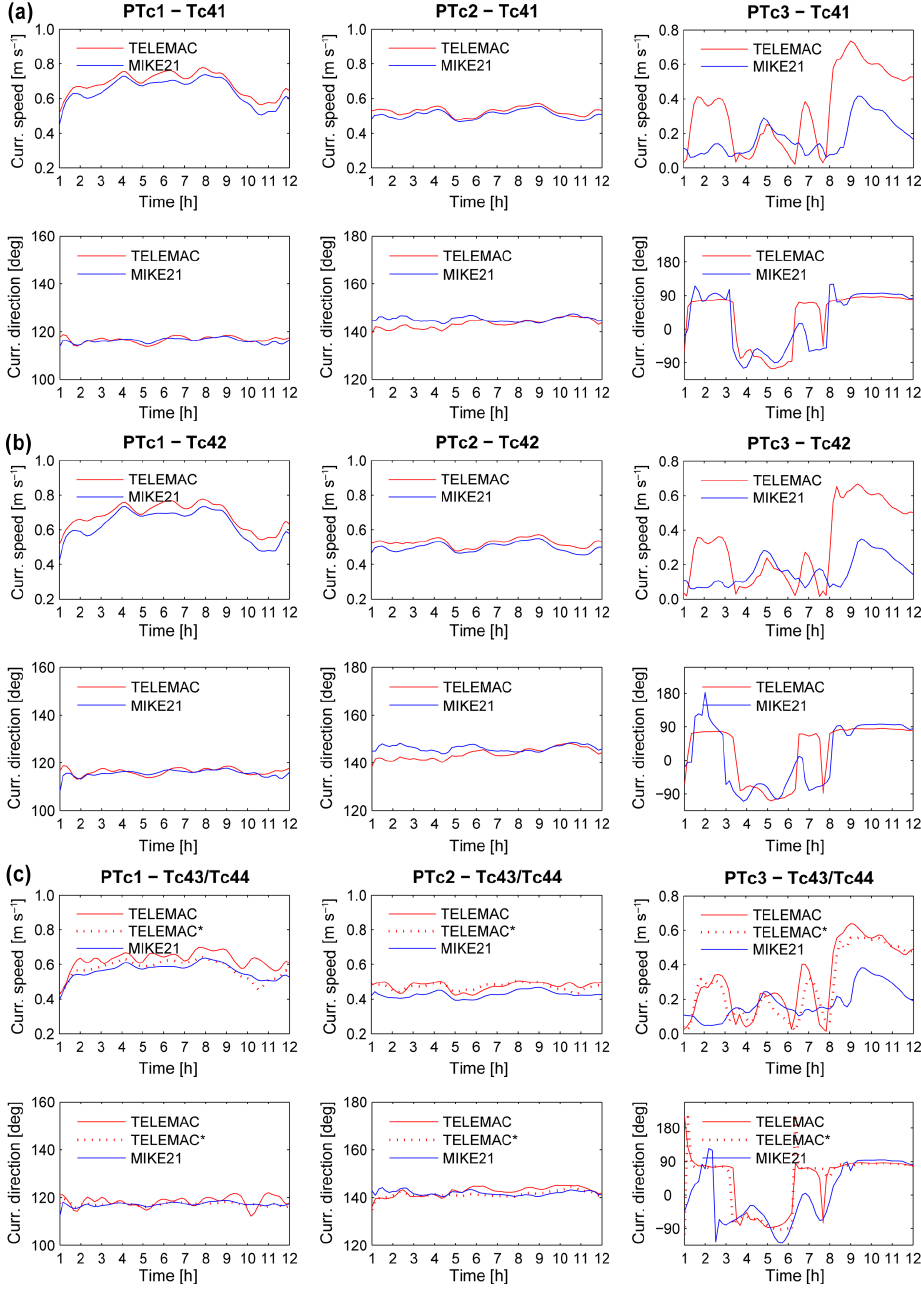
Figure 12. Comparison of TELEMAC and MIKE21 results (Curr. speed/direction) at points within the breaker zone (PTc1, PTc2, PTc3) for the Brindisi–Torre Guaceto case study for runs (a) Tc41, (b) Tc42 and (c) Tc43/Tc44 ∗